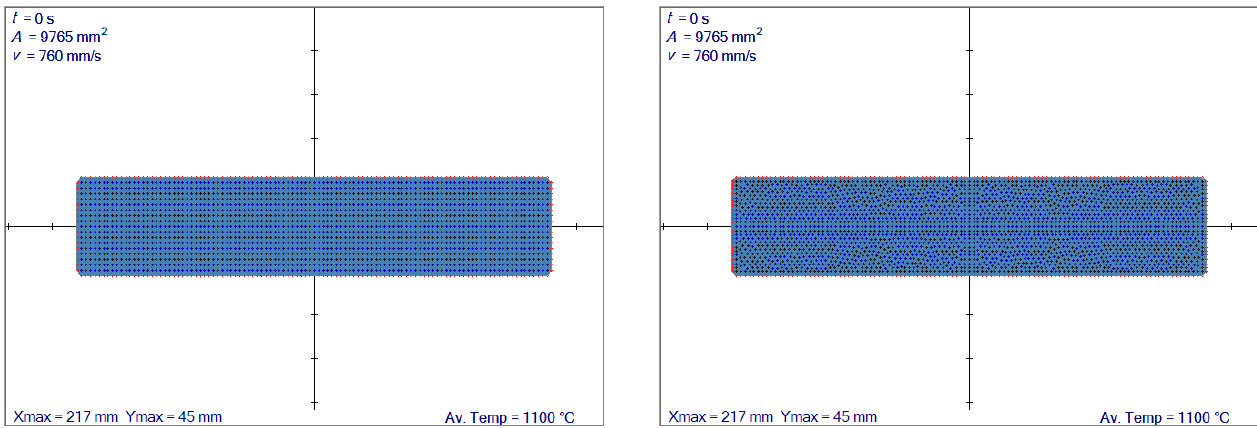
Figure 6. Comparison of different initial node arrangements. Regular node distribution (on the left ), irregular node distribution (on the right ). Av. Temp. stands for average temperature.